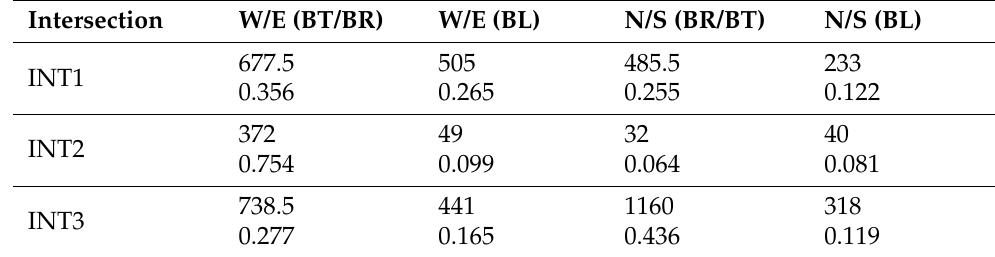
Table 4. Critical turning movements and their distribution for traffic signal design and treatment.